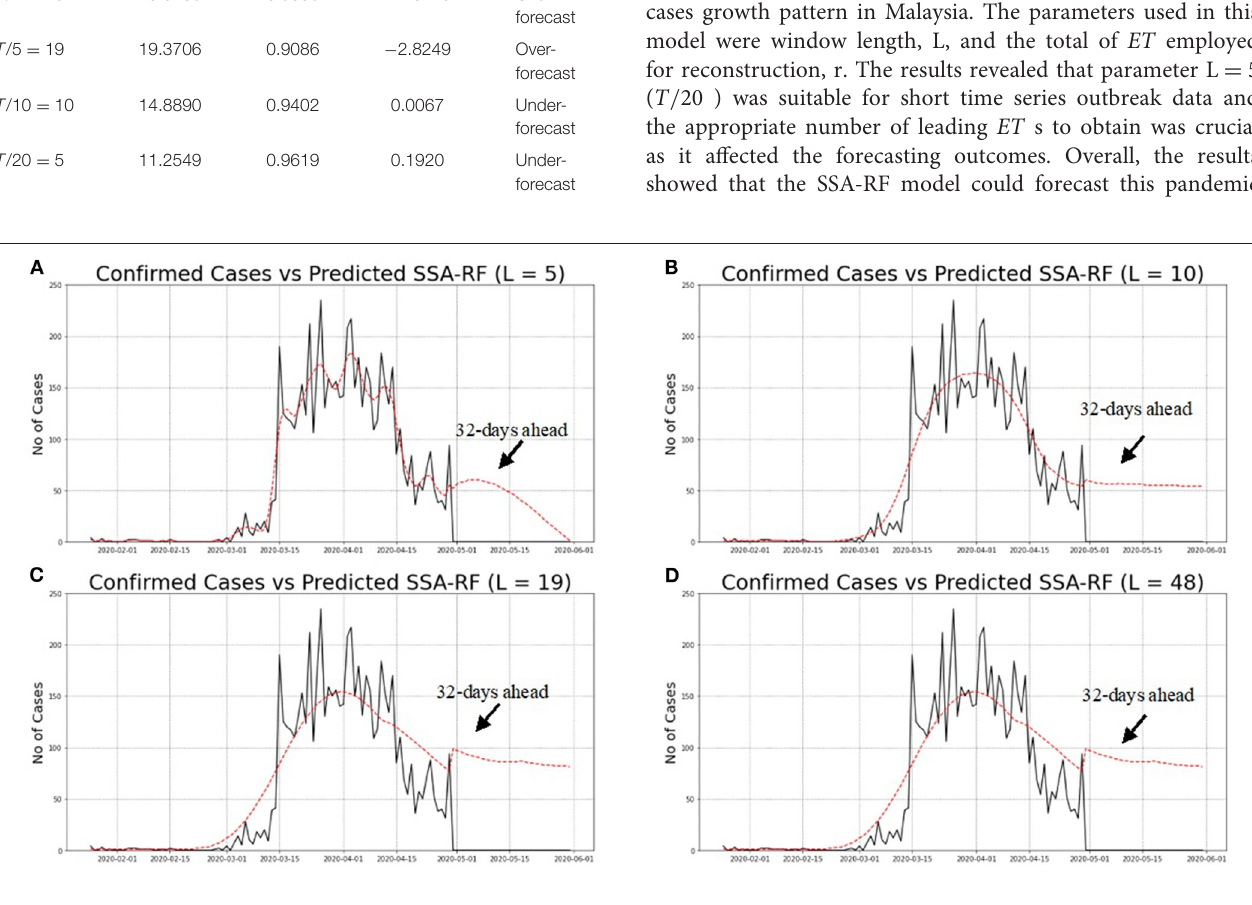
Frontiers in Public Health |